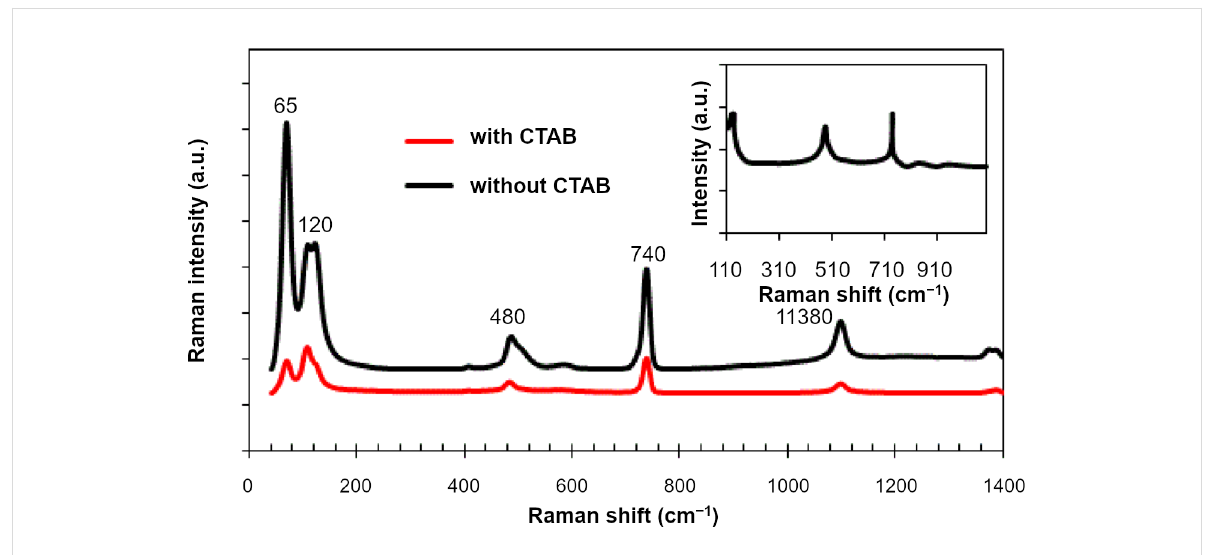
Figure 4: Raman spectra of Ag 2 S NPs prepared without and with CTAB. Inset is the Raman spectrum of thiourea solution.